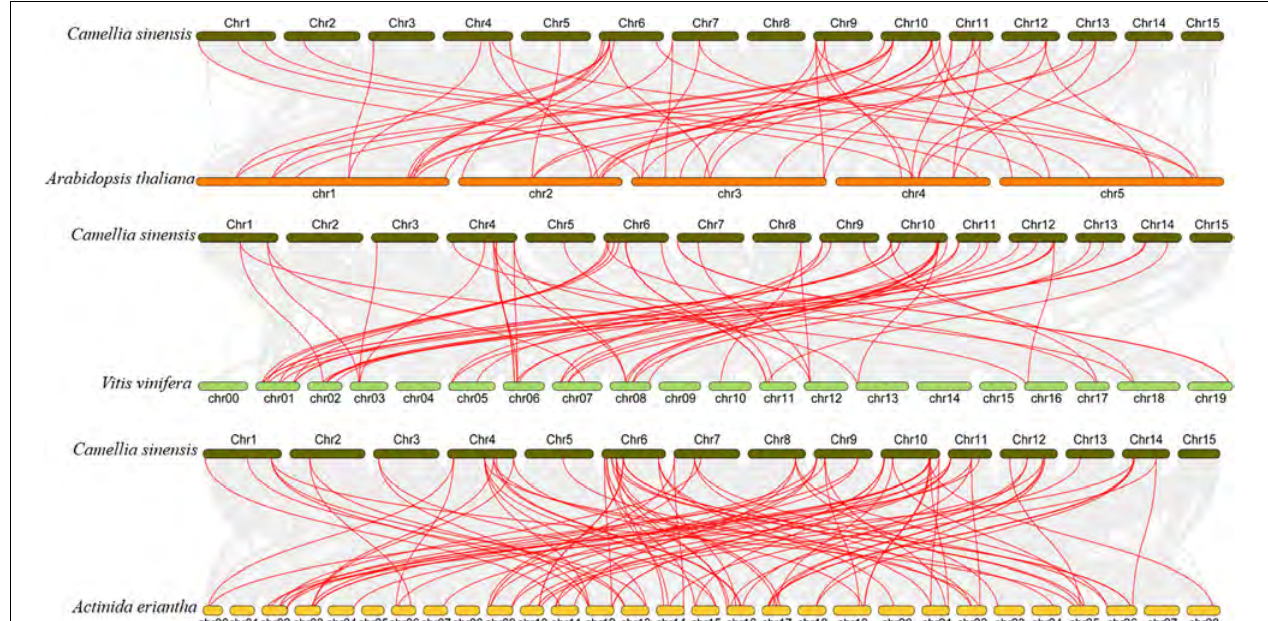
FIGURE 6 | Collinearity analysis of GARP genes between the tea plant genome and Arabidopsis , Vitis vinifera and Actinidia eriantha genomes. The gray lines in the background indicate the collinearity blocks between species. The collinear gene pairs are linked with red